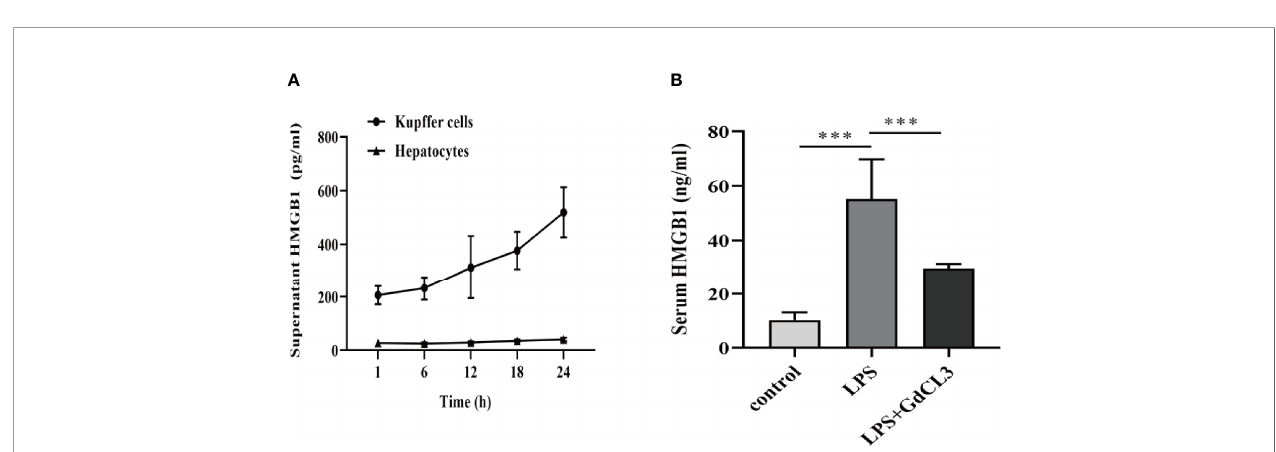
FIGURE 7 | Kupffer cells are the major HMGB1-secreting cells. (A) ELISA analysis of supernatant HMGB1 levels in primary rat Kupffer cells and hepatocytes following stimulation by LPS (1 m g/ml). (B) Rats were intraperitoneally administered with LPS (8 mg/kg) in the absence or presence of GdCl3 (20 mg/kg for 24 h before LPS injection) injection. Serum HMGB1 was measured by ELISA, 12 h after the injection. n = 6 for each group. One-way ANOVA was used to determine the statistical differences between groups. *** P <